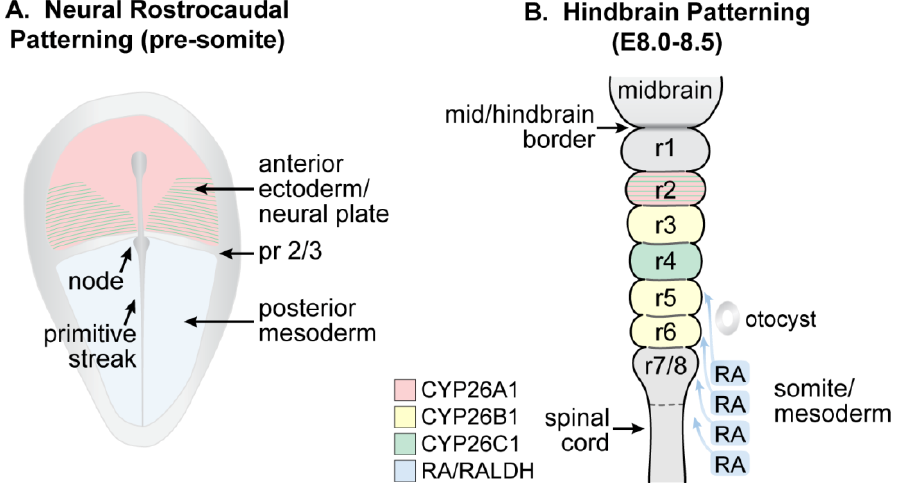
Figure 4. Schematic showing the location of RA and Cyp26 expression in a presomitic mouse embryo undergoing ( A ) patterning of the neural plate and ( B ) later during the course of hindbrain patterning. ( A ) RA generated by RALDH2 in the posterior mesoderm forms an early anterior boundary of activity in the neural plate at presumptive rhombomere (pr) 2/pr3, whereas Cyp26A1 and Cyp26C1 are expressed rostral to the pr2 border; ( B ) By E8.0 to E8.5, RA is being expressed by the somites and anterior presomitic mesoderm, and acts on the overlying hindbrain and spinal cord. The activity of the CYP26 enzymes regulate access of the neuroepithelium to RA (Adapted from